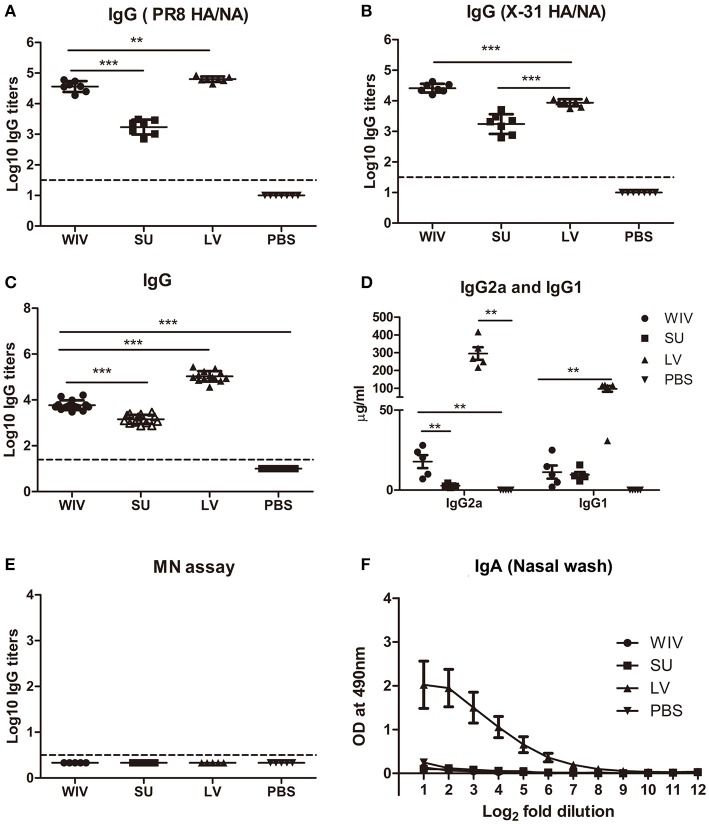
Cross-reactive antibody responses induced by sequential infection or immunization. On day 28 (the day of the second infection or immunization; A) and on day 56 (the day of sacrifice or challenge; B–F), serum samples and nasal washes were collected from the mice described in the legend to Figure 1. Anti-PR8 (HA/NA) IgG antibodies (A; n = 7) and Anti-X-31(HA/NA) IgG antibodies (B; n = 7) in serum samples were detected by ELISA using PR8 SU and X-31 SU for coating. Anti-H1N1pdm09-specific IgG (C; n = 15), IgG2a and IgG1 (D; n = 5) antibodies in serum samples were detected by ELISA. Microneutralization assay was used to determine the neutralizing ability of these antibodies toward A(H1N1)pdm09 virus (E; n = 5). Anti-H1N1pdm09 IgA antibody levels in nasal washes were determined by ELISA (F; n = 5). Data of individual animals (A–E) are depicted or mean values ± SEM (F) are given, **p < 0.01, ***p < 0.001. Mann-Whitney U-test. The dashed line represents the limit of detection.